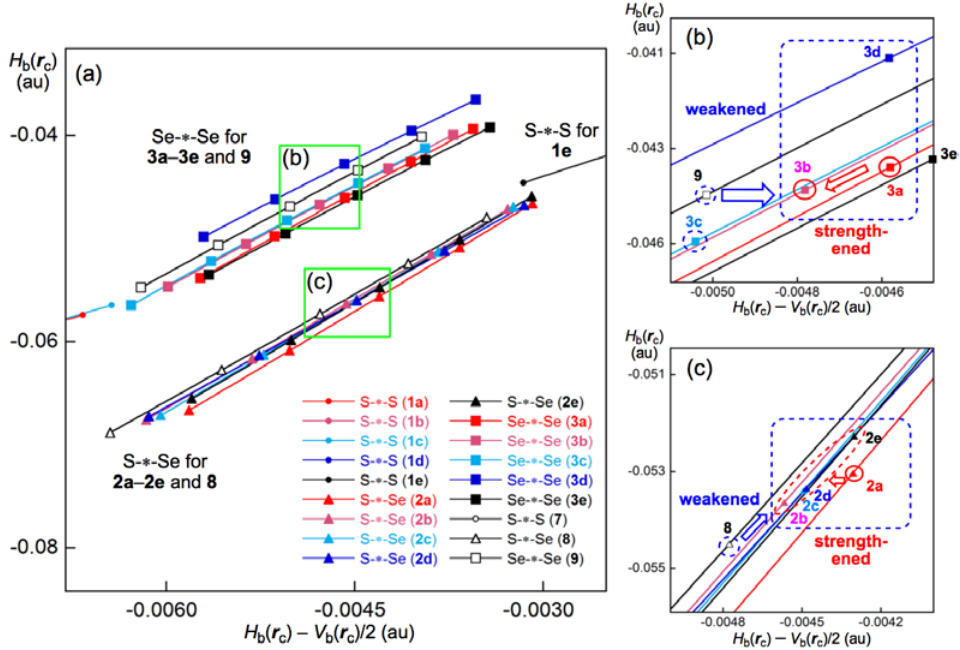
Figure 10. Plots of H b ( r c ) versus H b ( r c ) − V b ( r c )/2 for 2a – 3e , 8 and 9 . ( a ) Whole plot; ( b ) magnified view of the data around the fully optimized structures of 3a – 3e and 9 ; and ( c ) magnified view of the data around the fully optimized structures of 2a – 2e and 8 .